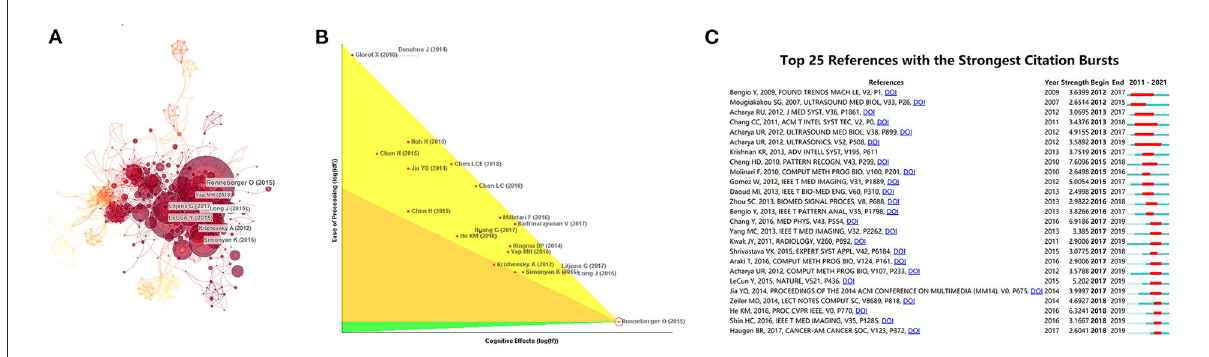
FIGURE5 The network of references with the highest number of citations. (A) Clustering analysis of literatures co-citation network based on CiteSpace. (B) Article with the highest citation rate was processed in-depth analysis. (C) Top 25 references with strongest citation bursts based on